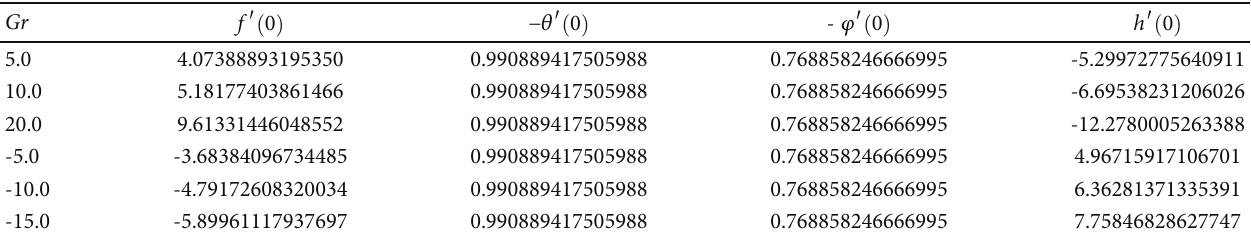
Table 2: Values of skin friction coe ffi cient, heat transfer and mass transfer for thermal Grashof number variation with γ = 45 ° , M = 2,